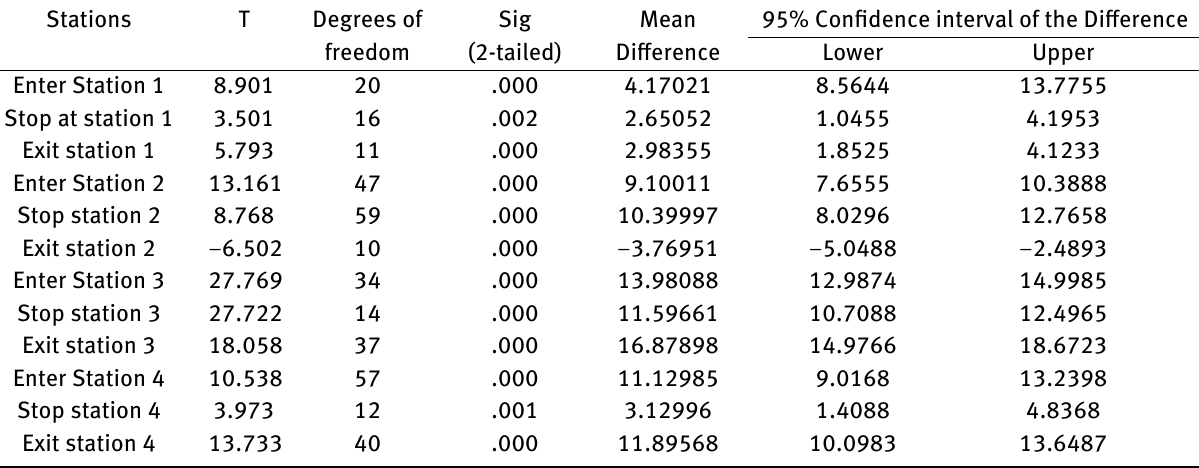
Table 2: One-sample mean comparison test for each group